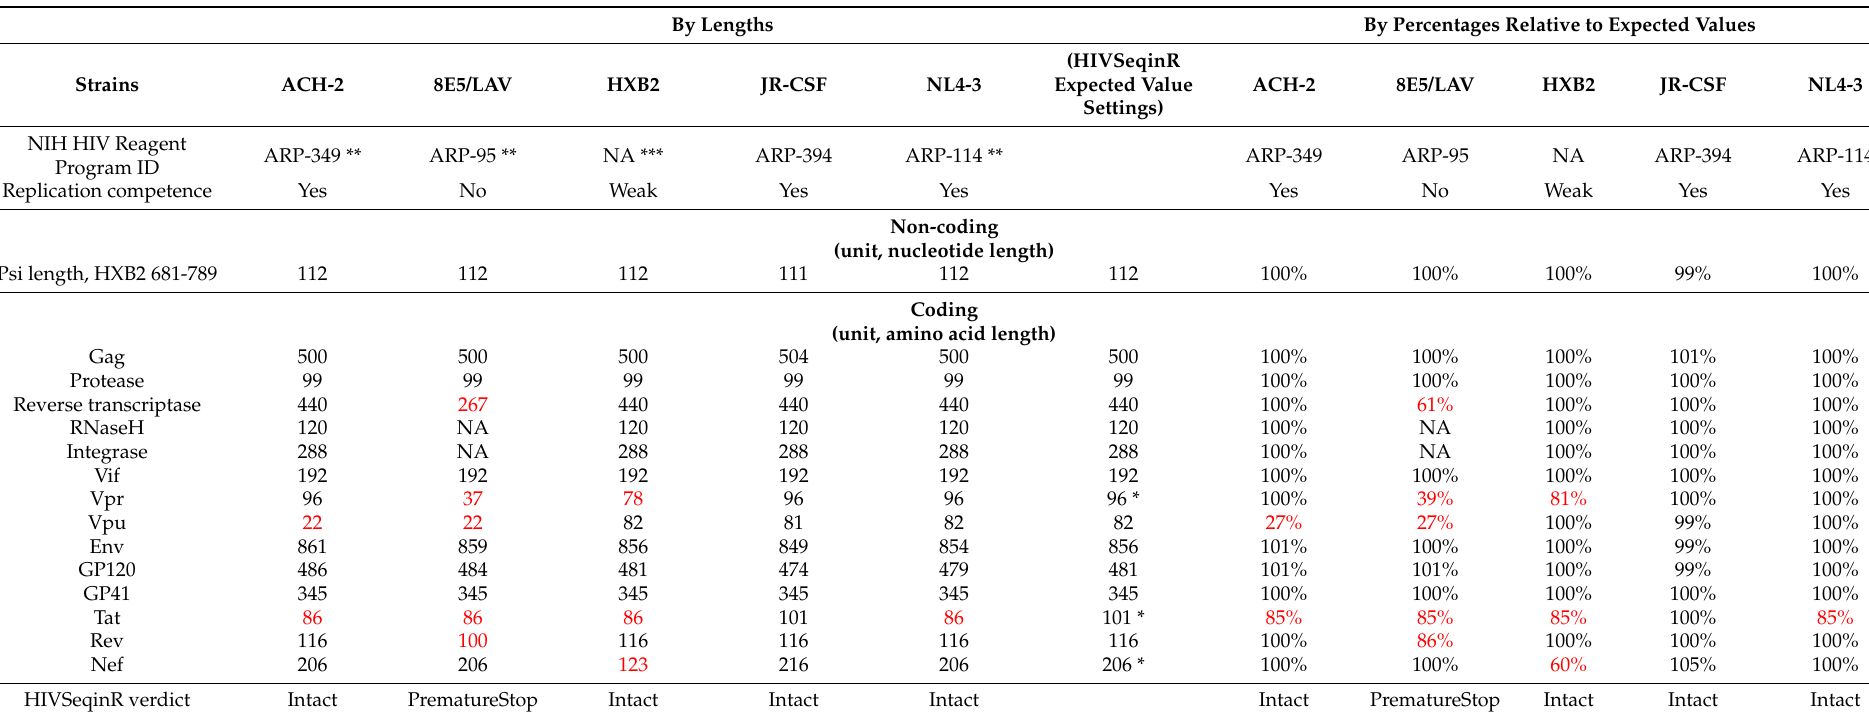
Table 1. Amino acid lengths of all HIV gene products and the lengths of the non-coding packaging signal in five commonly used lab/reference strains are summarized below. By Lengths By Percentages Relative to Expected Values Strains ACH-2